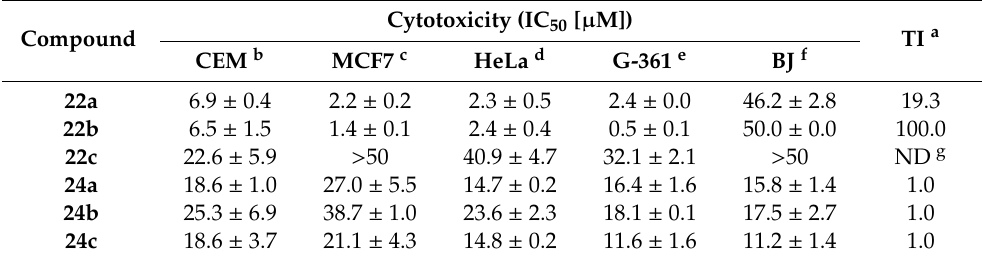
a Therapeutic index (TI) calculated for G-361 line versus fibroblasts BJ, b CEM, cells of human T-lymphoblastic leukemia, c MCF7, cells of human breast adenocarcinoma, d HeLa, cells of human cervical cancer, e G-361, human malignant melanoma cell line f BJ, normal human fibroblasts, g ND = not determined.